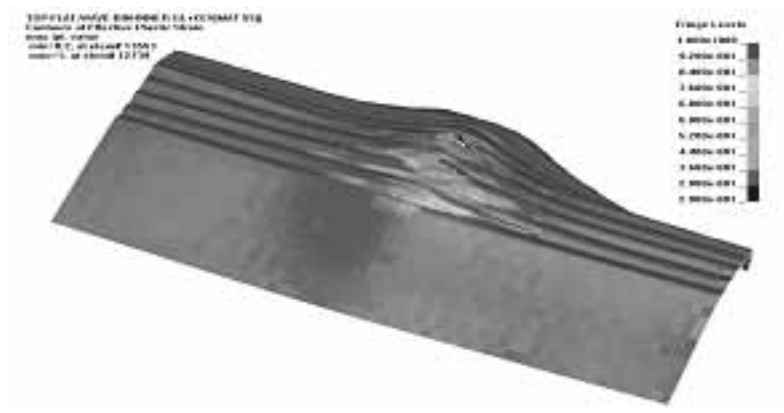
Fig. 32. Basic shield after test (inside view).